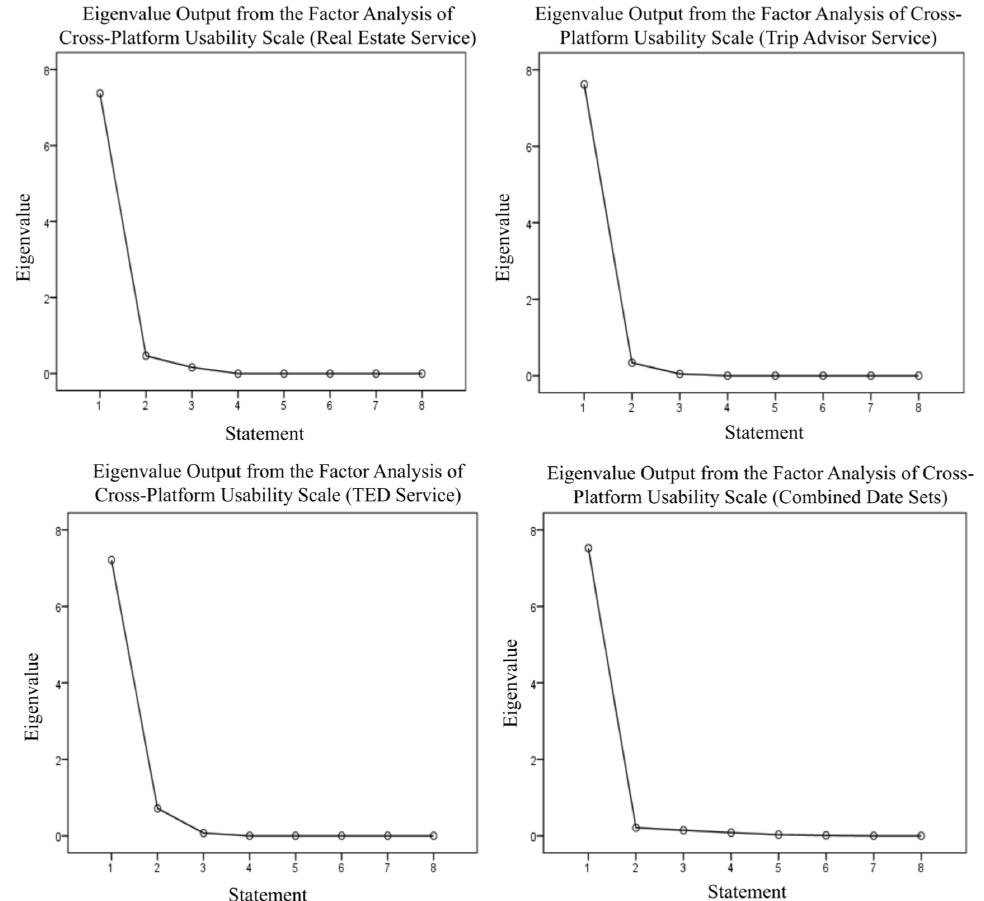
Figure 4. Factor analysis Eigenvalue output from the CPUS